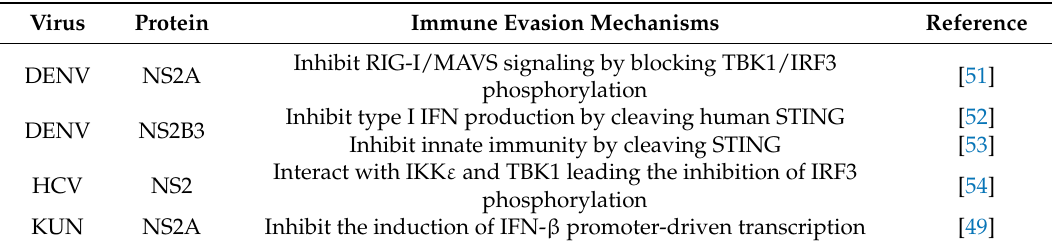
Table 1. Immune evasion by flaviviridae